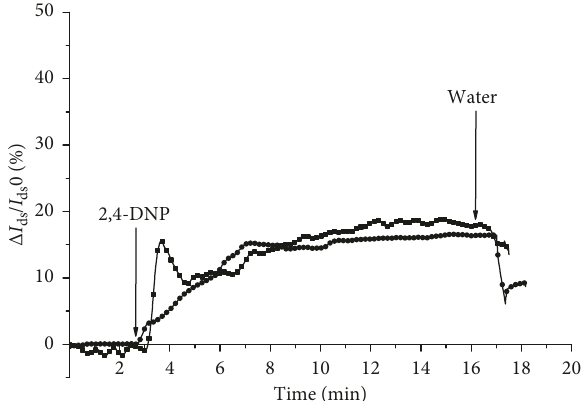
Figure 4: Time dependencies of the normalized differential signal from the SOI-NW sensor obtained upon repeated detection of DNP. Experimental conditions: DNP concentration 3.0 × 10 − 14 M in deionized water; V g � 20V, V ds � 0.2V total solution volume in the cell 450 μ L. Arrows indicate addition of DNP solution and wash with water.